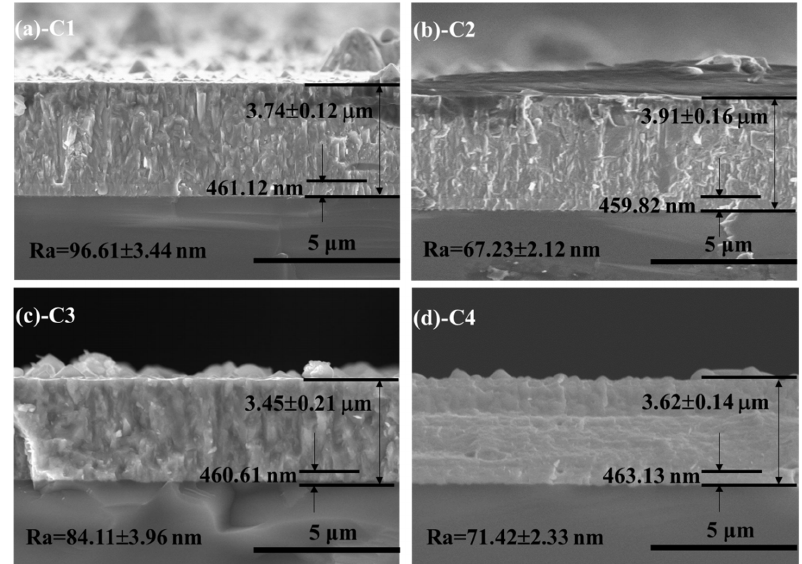
Figure 1. Cross-section morphology, thickness and surface roughness of all CrN films on Si (100) wafers: ( a ) C1; ( b ) C2; ( c ) C3; ( d ) C4.